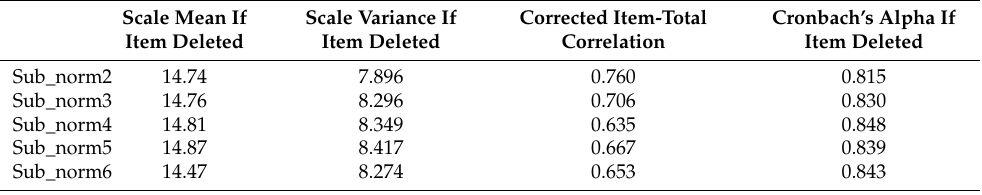
Table 4. Cronbach’s Alpha of Sub_norm after removing Sub_norm1, Sub_norm7 and Sub_norm8.